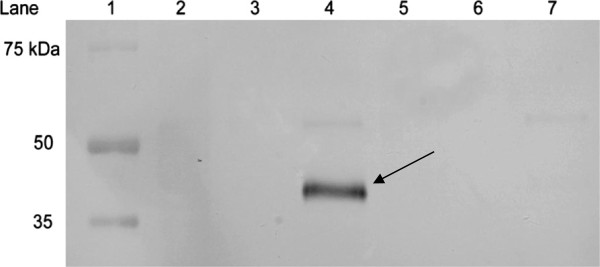
Western blot stained with a rabbit polyclonal antibody for polygalacturonase. Lane 1, Precision Plus Dual Protein Standard; lanes 2, 3, 4, ‘Royal Gala’ in the order of fruitlet, mature and ripe fruit; lanes 5, 6, 7, ‘Scifresh’ in the order of fruitlet, mature and ripe fruit. An arrow indicates the presence of PG protein at 45 kDa only detected in ripe ‘Royal Gala’ fruit.